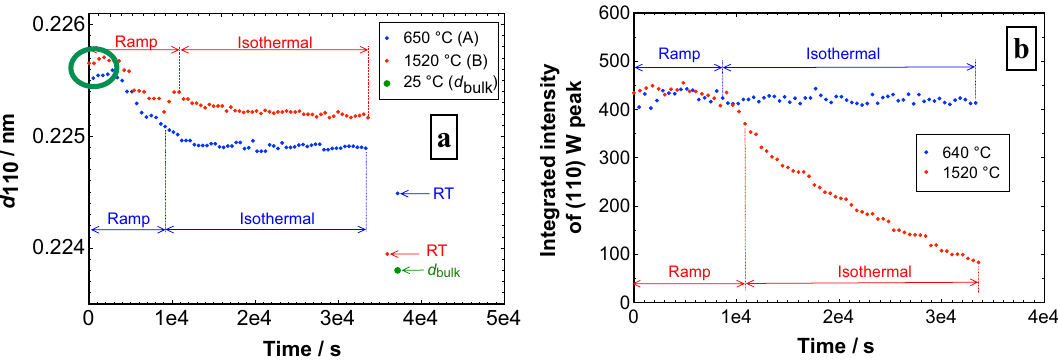
Figure 5. ( a ) Interplanar spacing d 110 of bcc W in the 3-layer-system as a function of time during annealing up to 650 °C (blue markers) and 1520 °C (red markers). The duration of the isothermal part was about 6 h. The green ellipse highlight the initial increase in d-values due to thermal expansion below 200 °C. ( b ) Integrated intensity of (110) bcc W in 3-layer-systems annealed for 6 h at temperatures 650 °C (blue markers) and 1520 °C (red